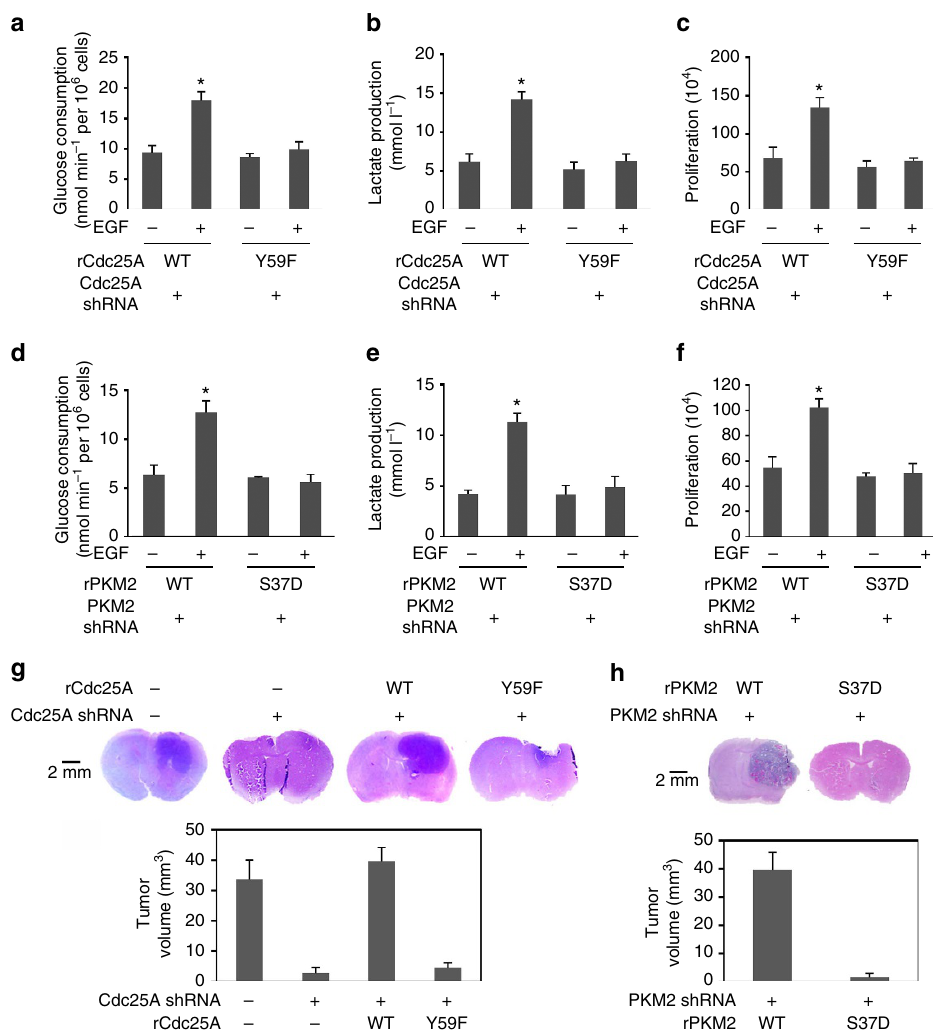
Figure 6 | Cdc25A-mediated PKM2 pS37 dephosphorylation promotes the EGF-induced Warburg effect and tumorigenesis. ( a , b , d , e ) Cdc25A-depleted U87/EGFR cells with the reconstituted expression of rCdc25A WTor rCdc25AY59F or PKM2-depleted U87/EGFR cells with the reconstituted expression of rPKM2 WTor rPKM2 S37D were incubated with no serum DMEM in the presence or absence of EGF (100ngml (cid:2) 1 ) for 20h. The media were collected for analysis of glucose consumption ( a , d ) or lactate production ( b , e ), which was normalized by cell numbers (per 10 6 ). Data represent the means ± s.d. of three independent experiments. * P o 0.05: statistically significant value in relation to the corresponding cells without EGF treatment. ( c , f ) A total number of 2 (cid:3) 10 4 Cdc25A-depleted U87/EGFR cells with the reconstituted expression of rCdc25AWTor rCdc25AY59F or PKM2-depleted U87/EGFR cells with the reconstituted expression of rPKM2 WT or rPKM2 S37D were plated and counted 7 days after seeding in DMEM with 0.5% bovine calf serum in the presence or absence of EGF (100ngml (cid:2) 1 ). Data represent the means ± s.d. of three independent experiments. * P o 0.05: statistically significant value in relation to the corresponding cells without EGF treatment. ( g , h ) A total number of 5 (cid:3) 10 5 Cdc25A-depleted U87/EGFRvIII cells with the reconstituted expression of rCdc25A WTor rCdc25A Y59F ( g ), or PKM2-depleted U87/EGFRvIII cells with the reconstituted expression of rPKM2 WTor rPKM2 S37D ( h ) were intracranially injected into randomized athymic nude mice. After 2 weeks, the mice were euthanized and tumour growth was examined. Hematoxylin and eosin-stained coronal brain sections show representative tumour xenografts (top panel). Tumor volumes were calculated (bottom panel). Data represent the means ± s.d. of seven